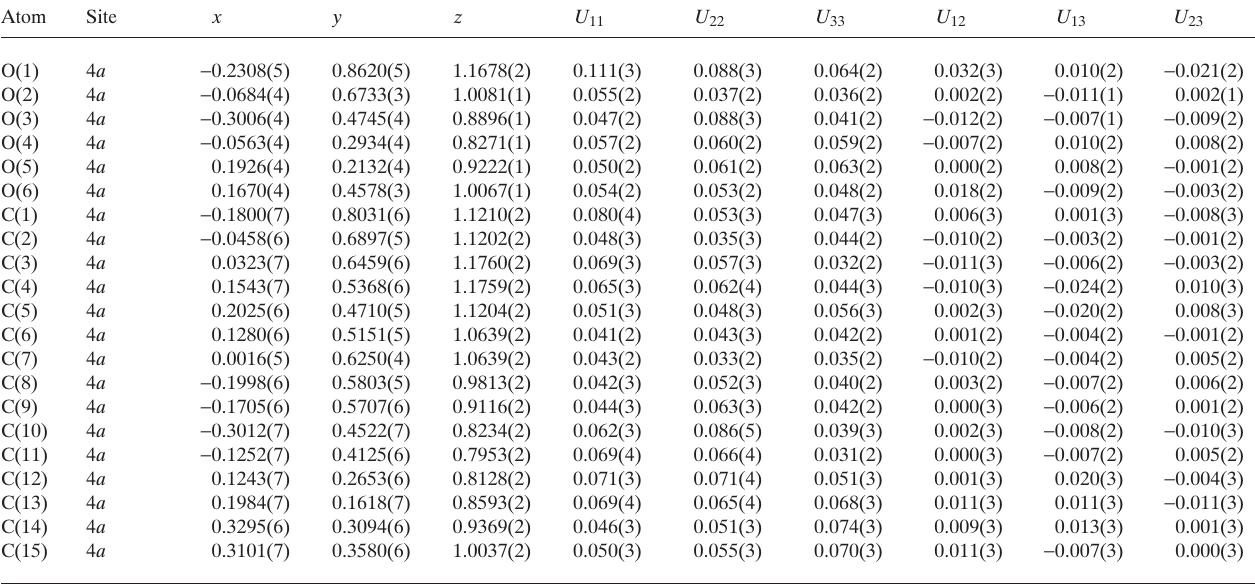
Table 3. Atomic coordinates and displacement parameters (in Å 2 )